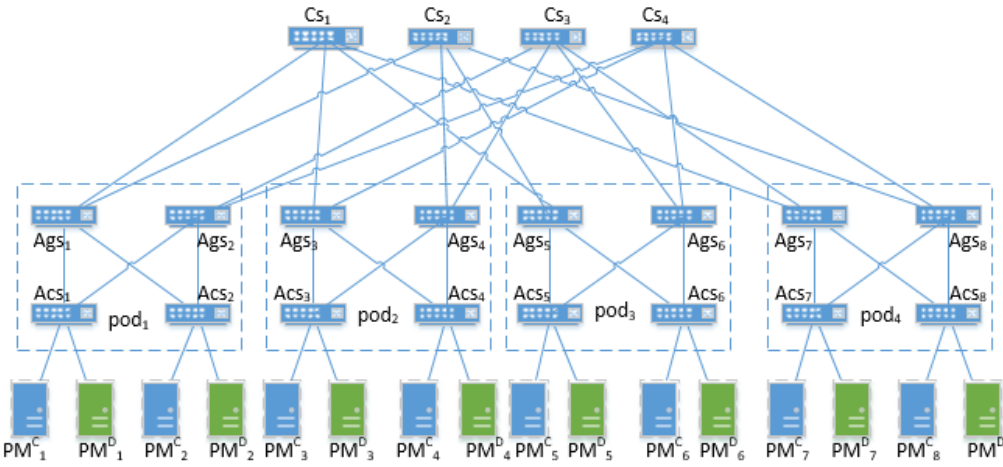
Figure 3. Network topology based on fat-tree.